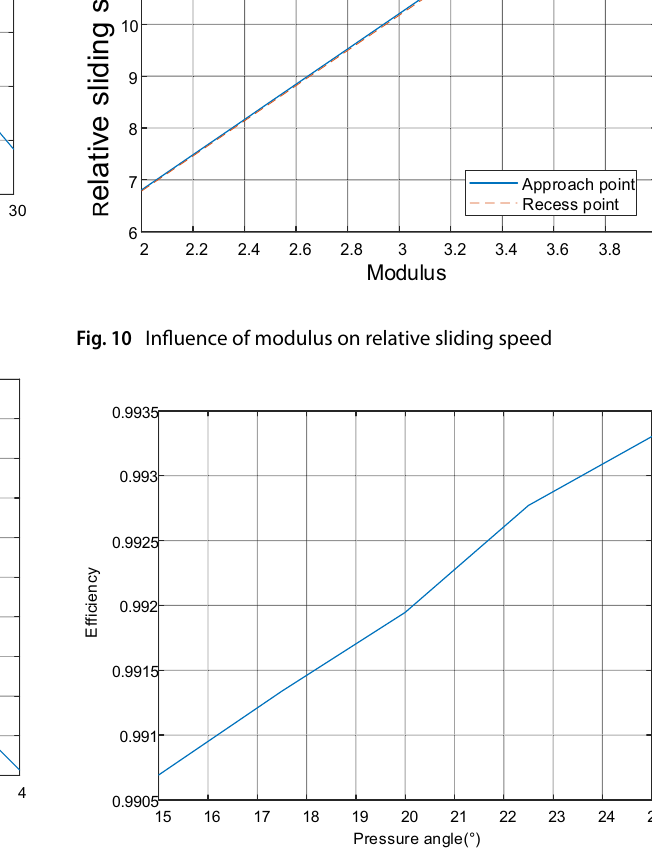
Fig. 11 Influence of pressure angle on transmission